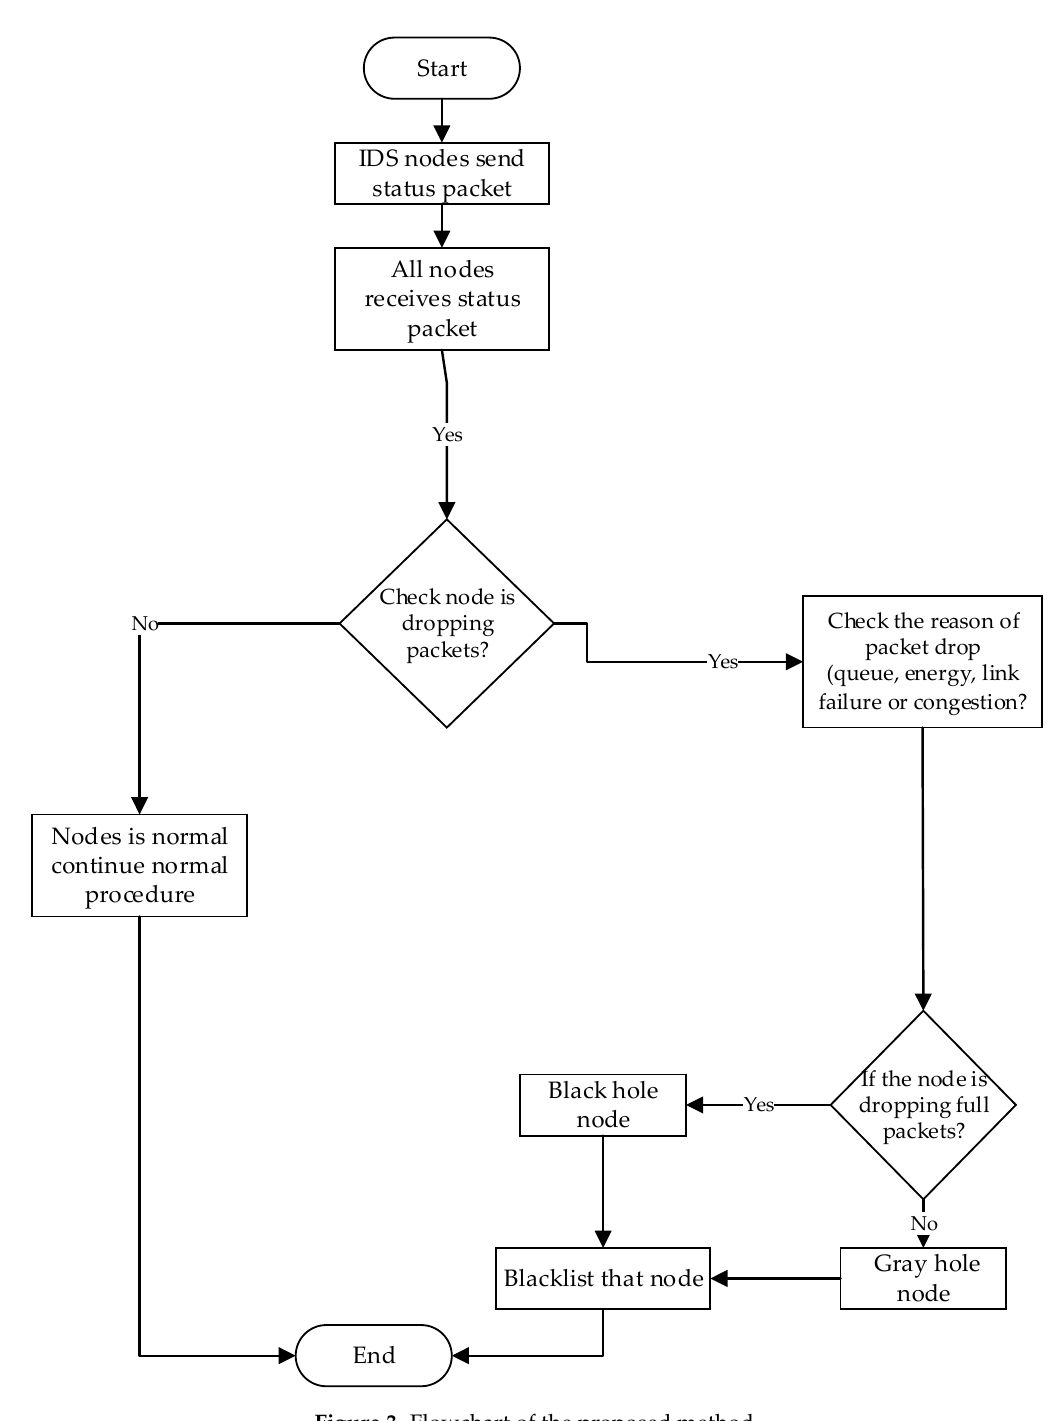
Figure 3. Flowchart of the proposed method.